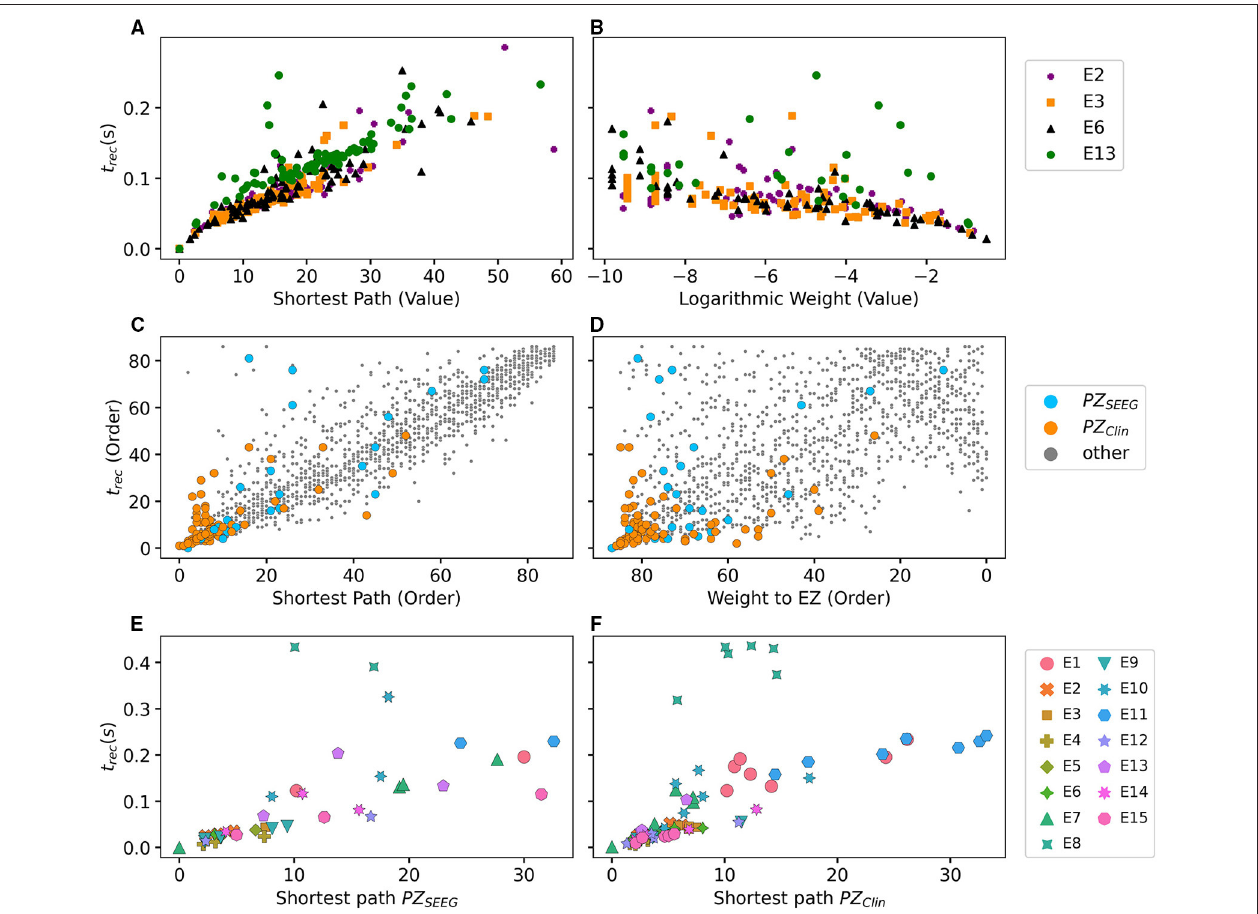
FIGURE 13 | Relationship between network measure and recruitment time, as found via numerical experiments. (A) Shortest path to EZ; (B) Logarithmic value of the weight to the EZ for the four patients with a single-node EZ. In (A) all four EZs are shown at (0, 0), while in (B) the EZs are omitted. The recruitment time is calculated in seconds after the perturbation current has started. In (C,D) the recruitment time values are plotted according to their order, as a function of the shortest path to EZ (C) and weight to EZ (D) for all 15 patients. In (D) the x -axis was inverted for better comparison. (E) Recruitment times t rec of the areas belonging to PZ SEEG and (F) PZ Clin as a function of the shortest path length to EZ, for all 15 patients. For patients with several nodes detected in the EZ, all areas were stimulated simultaneously. Parameters as in Figure 10